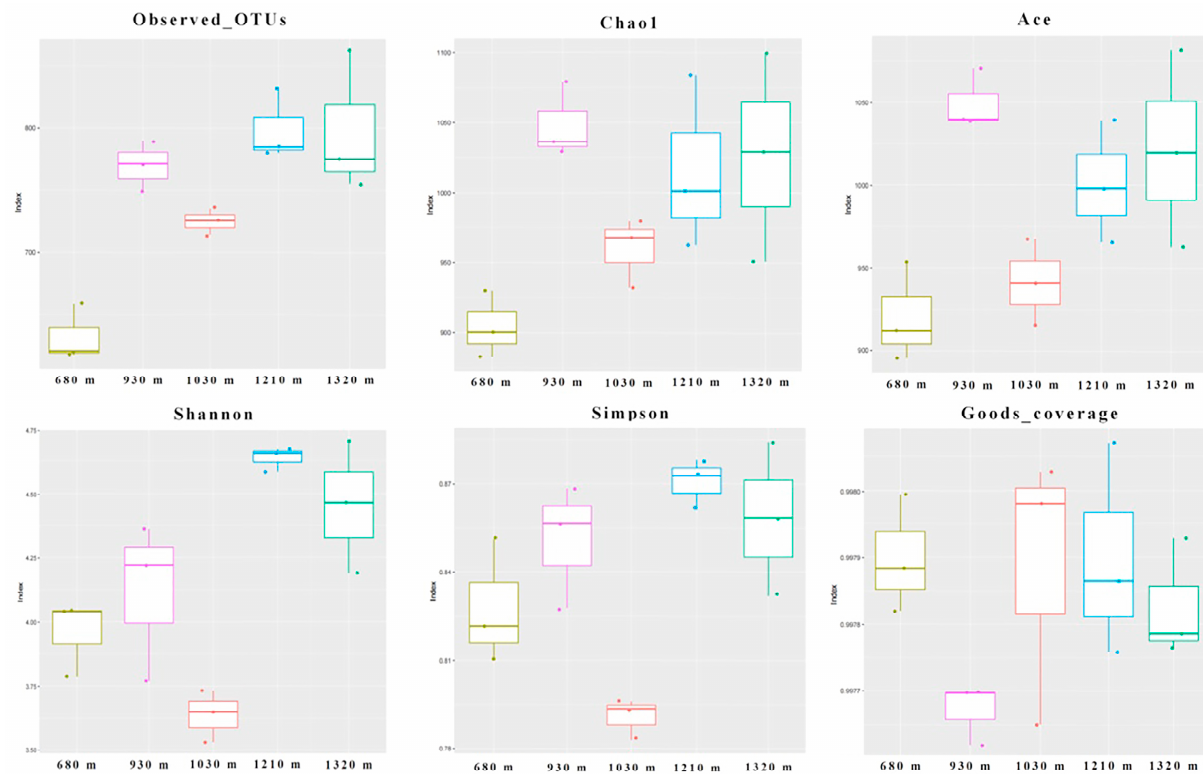
Figure 6. Alpha diversity indices of the fungal communities (based on ITS regions) in the C. arabica rhizospheric soil samples at different altitudes. Data are presented for the rhizospheric soil samples collected at altitudes of 680, 930, 1030, 1210, and 1320 m.